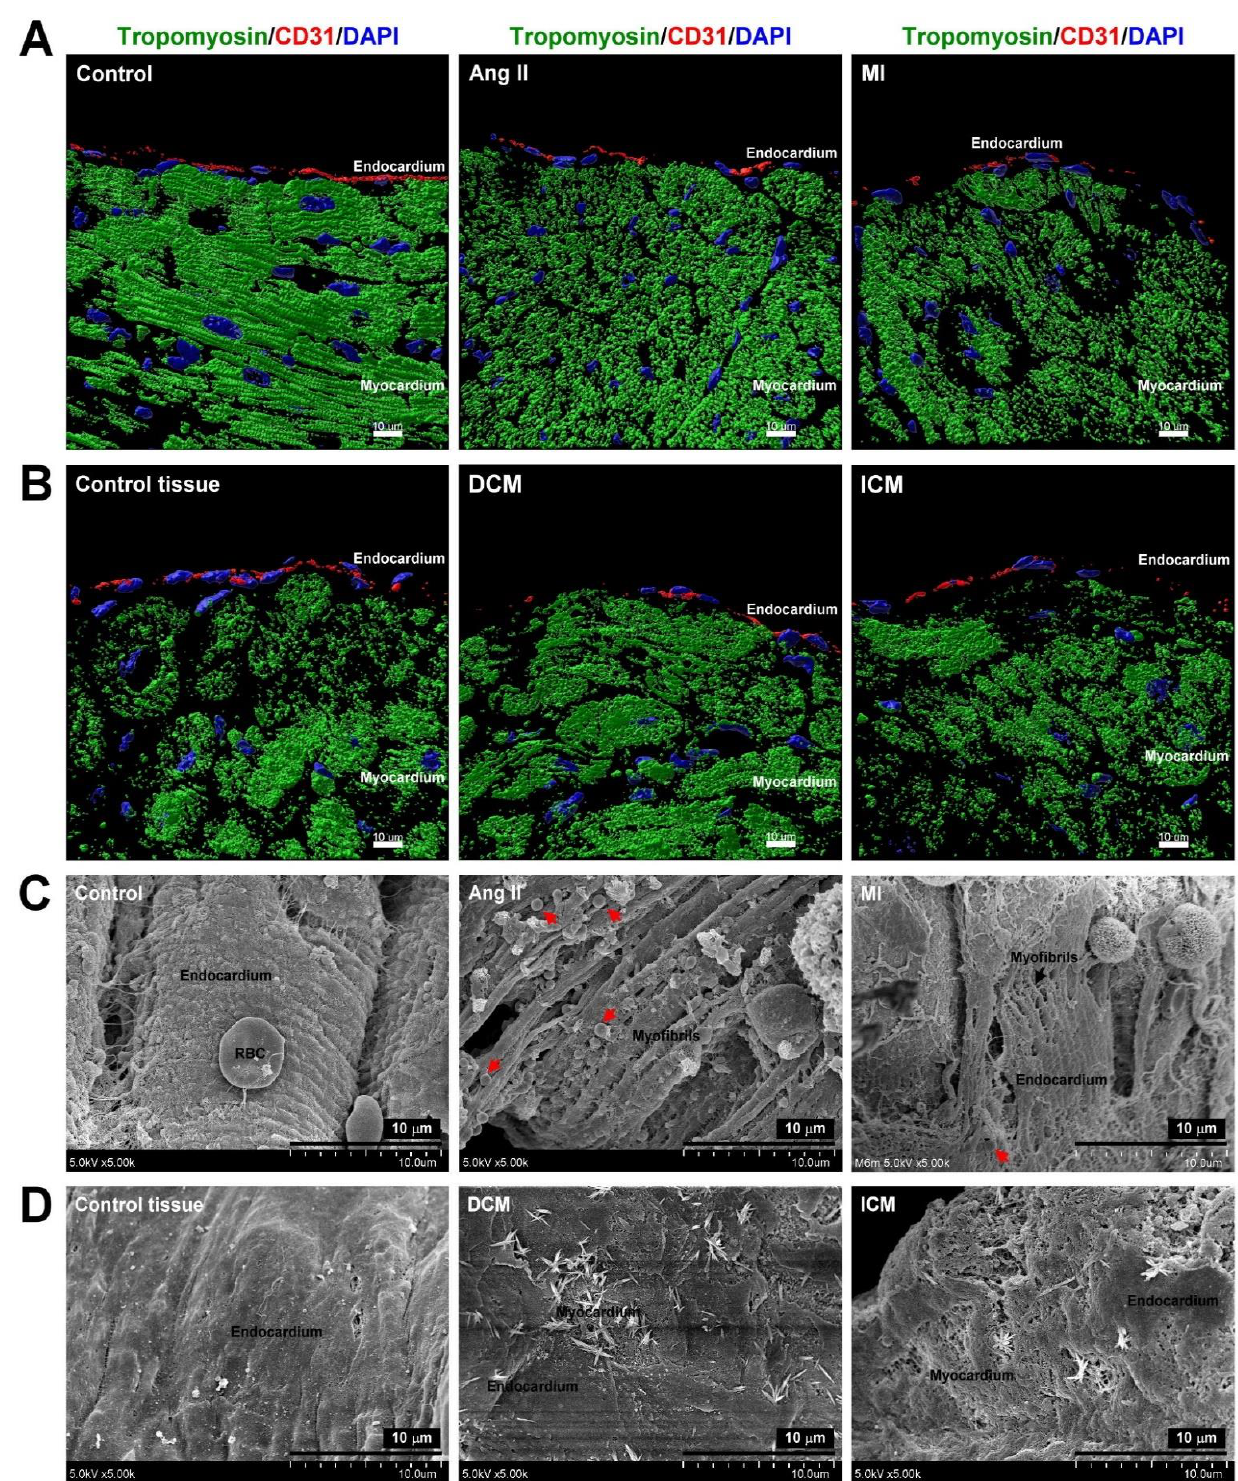
Figure 1. Endocardial endothelial dysfunction in HF. Immunostaining of CD31 (endocardium marker, red), tropomyosin (myocardium marker, green), and DAPI (DNA, blue) in rat HF heart model ( A ) and human HF heart tissues ( B ). Scanning electron microscopy (SEM) images of rat HF heart model ( C ) and human HF heart section ( D ). Red arrow indicates the mitochondria. Scale bar: 10 μm.